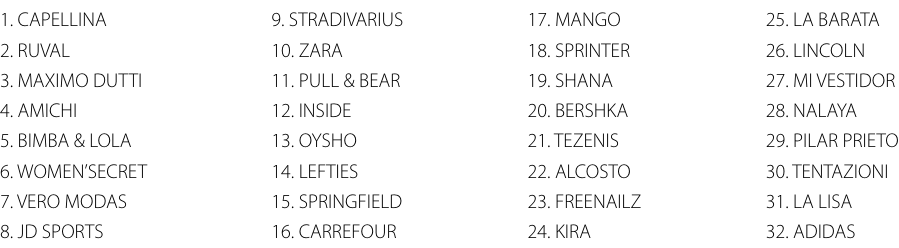
Table 1 Apparel’s establishments selected. Source: own